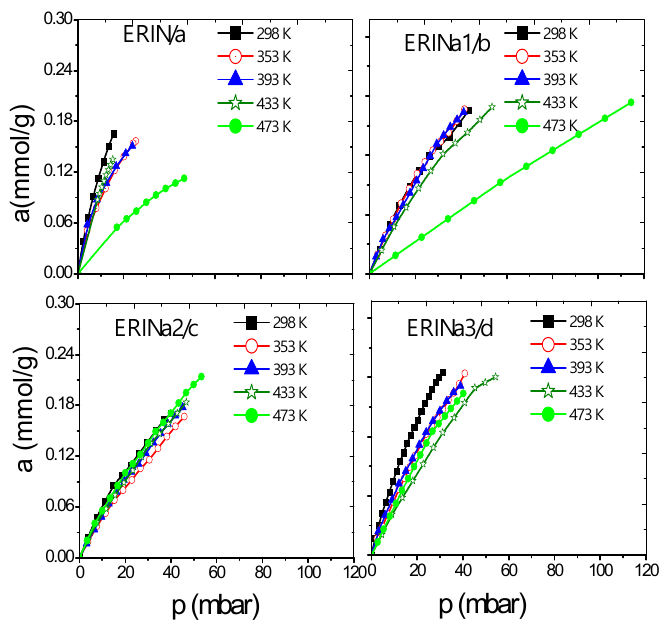
Figure 7. CH 4 adsorption isotherms at different temperatures on: ( a – c ) ERICa and ( d – f ) ERIMg exchanged zeolites.